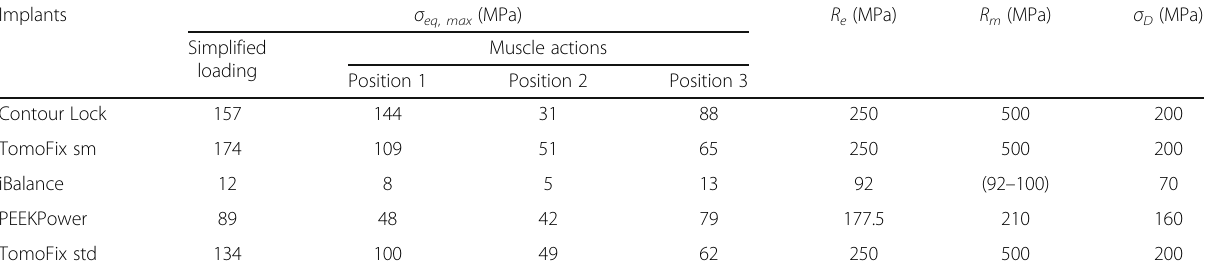
Table 4 Comparative summary of the maximal equivalent von-Mises stresses in the implants and the corresponding material strength values Implants σ eq , max (MPa) R e (MPa) R m (MPa) σ D (MPa) Simplified Muscle actions loading Position 1 Position 2 Position 3 Contour Lock 157 144 31 TomoFix sm 174 iBalance PEEKPower 89 48 TomoFix std 134